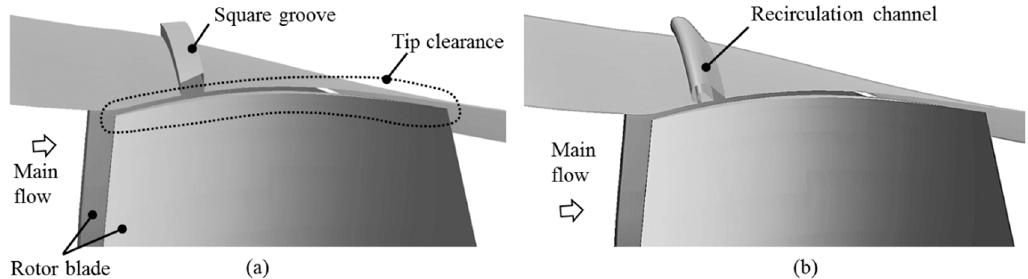
Figure 3. Overview of the casing treatments applied over the NASA stage 37 rotor. ( a ) Square groove [18]; ( b ) recirculation channel.